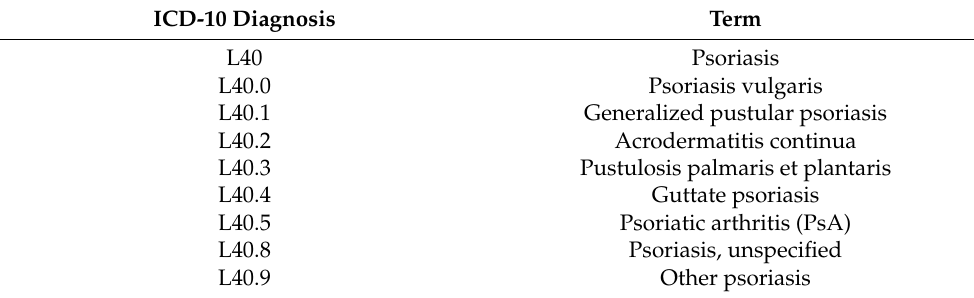
Table 1. Psoriasis diagnosis (ICD-10).